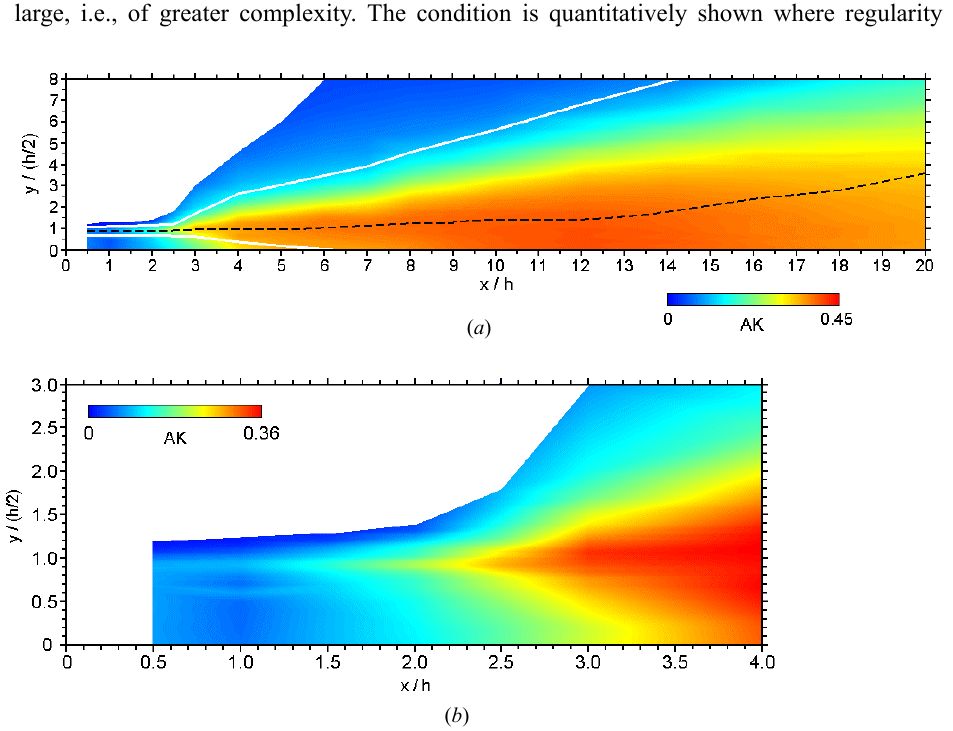
Fig. 7 Isocontour maps of approximated Kolmogorov